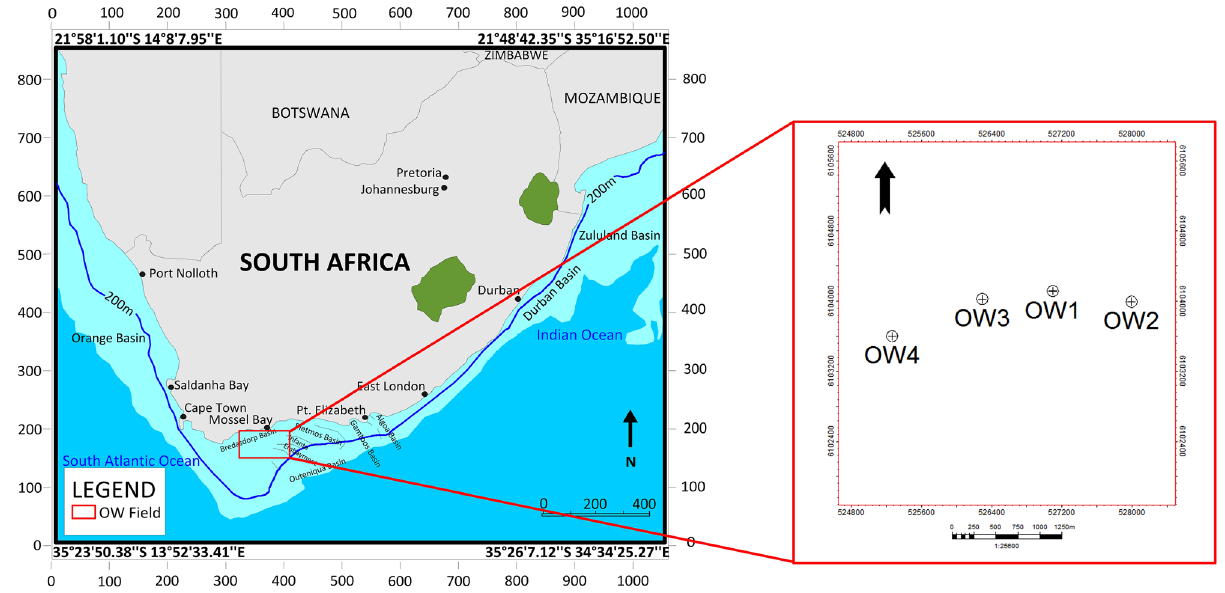
Figure 1. Location map generated from Petrel 2018.2 software (https:// usoft ly. com/ produ cts/ reser voir- engin eering/ schlu mberg er- petrel- 2018-2-7), showing the study area, including the well locations offshore of South Africa, modified after 32